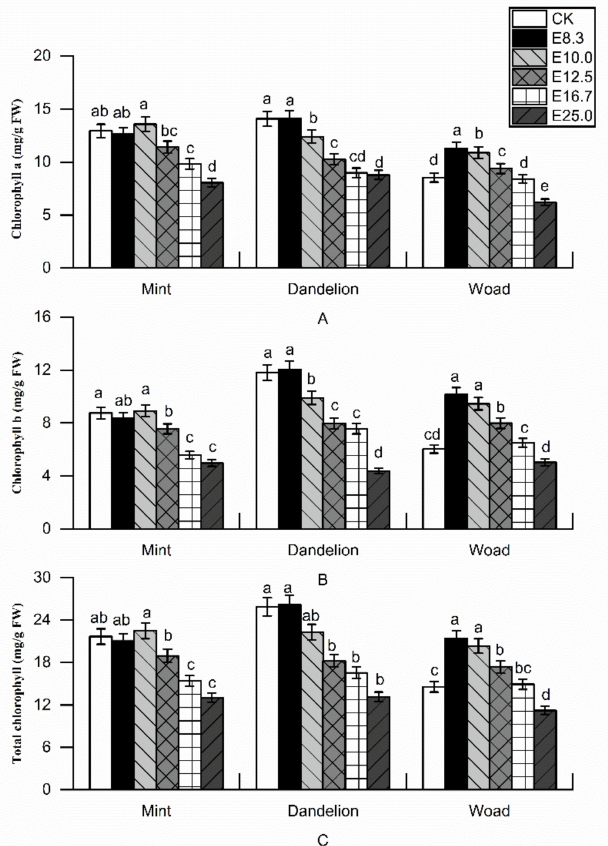
Figure 4. Effect of leaf aqueous extract of fig tree on the content of ( A ) chlorophyll a, ( B ) chlorophyll b and ( C ) total chlorophyll of three medicinal plants. Values are reported as mean ± SD, n = 3. CK, 0.0g/L; E8.3, 8.3 g/L; E10.0, 10.0 g/L; E12.5, 12.5 g/L; E16.7, 16.7 g/L; E25.0, 25.0 g/L. Lowercase letters represent significant differences in each treatment group ( p <